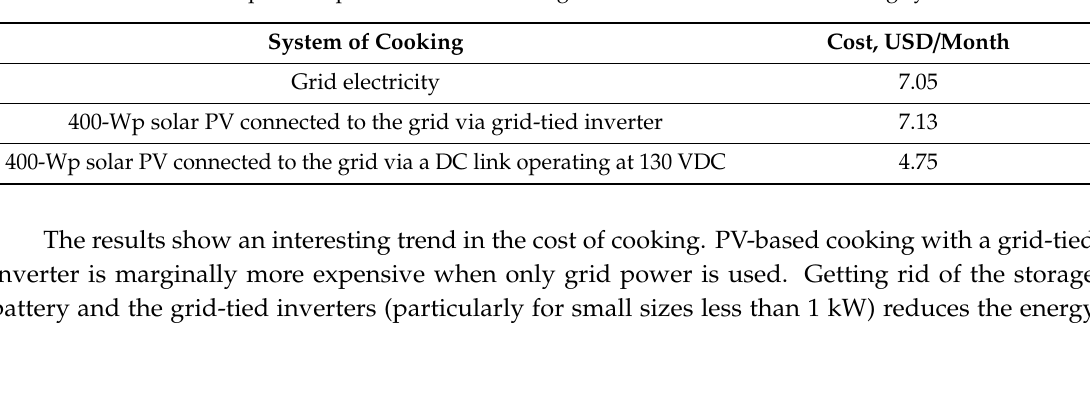
Table 8. A comparative presentation of cooking cost for di ff erent electric cooking